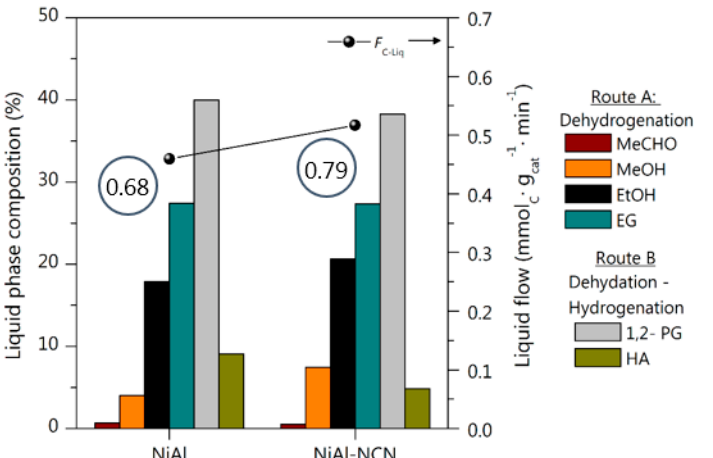
Figure 7. Molar composition of the main liquid products and total produced liquid flow. In circles: Route A/Route B product ratio. Reaction conditions: 235 °C/35 bar, WHSV = 24.5 h − 1 . Reaction time: 3 h TOS.